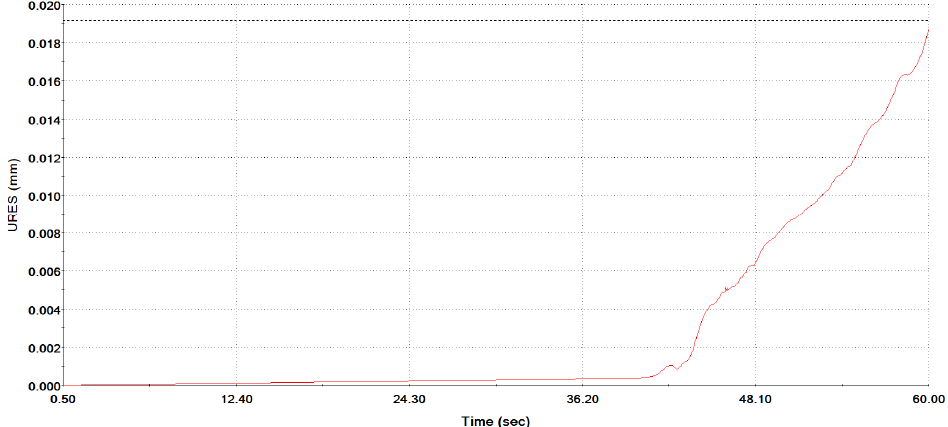
Figure 33. Graph of the change in the displacement in the node number 34331, reflecting the center